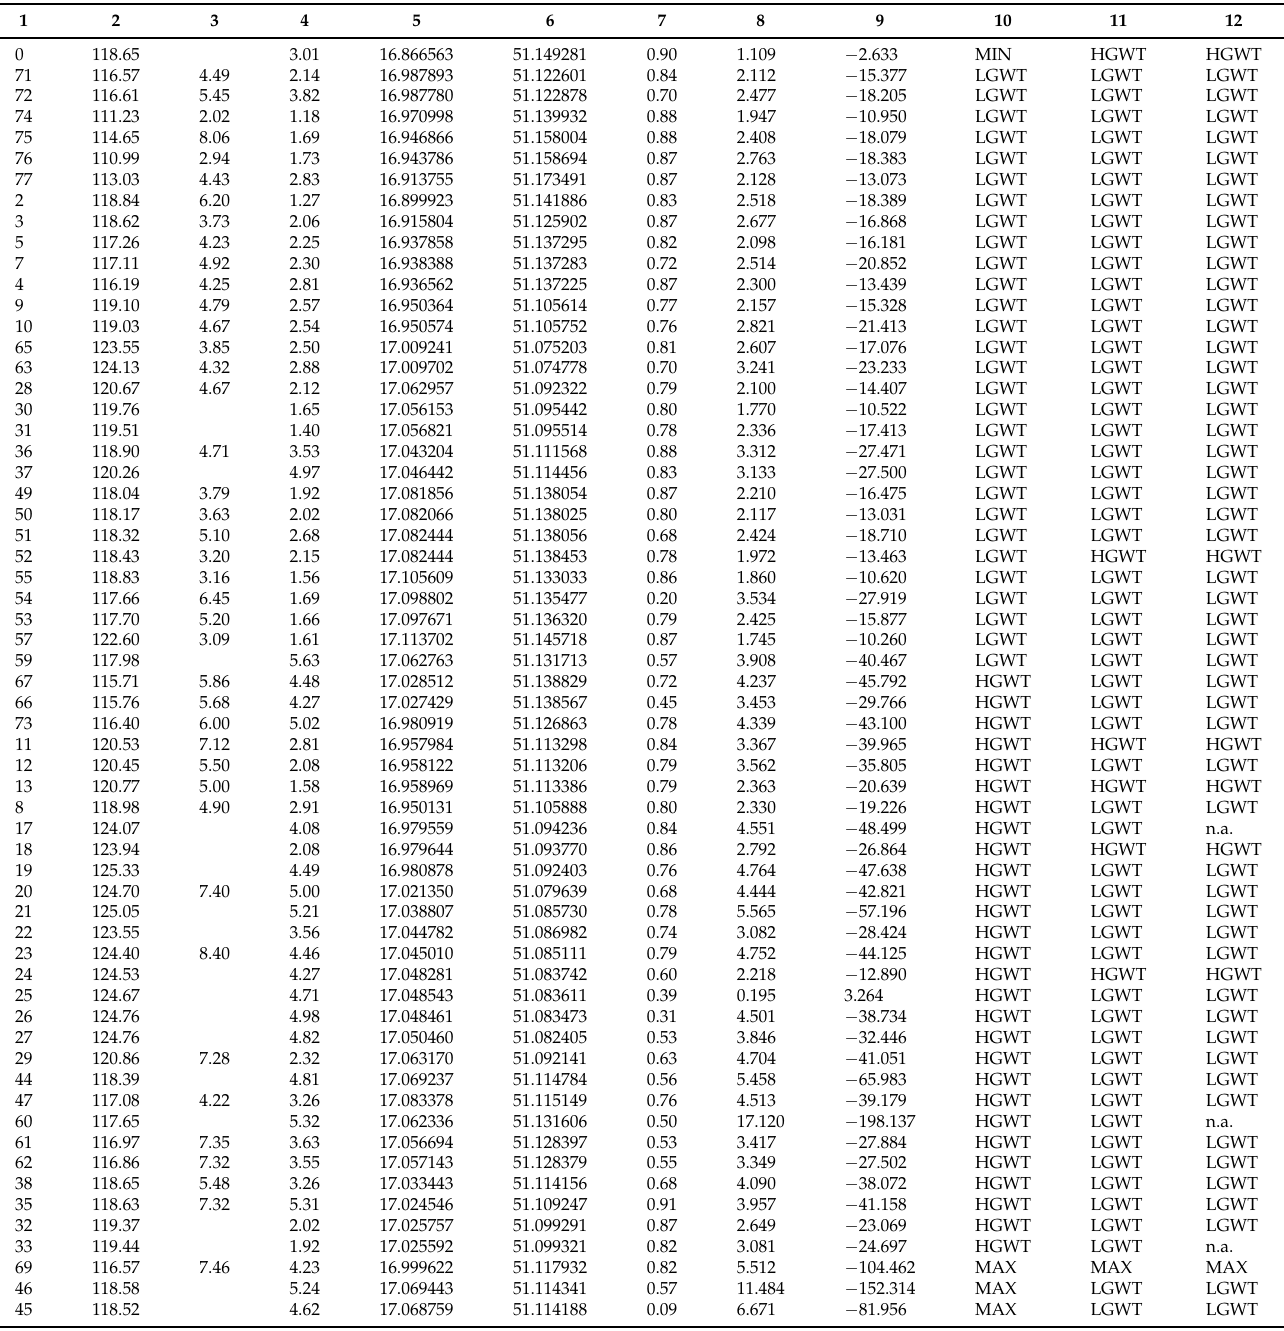
Table A1. Detailed information on measuring points. Columns: 1—Unique ID, 2—Height above